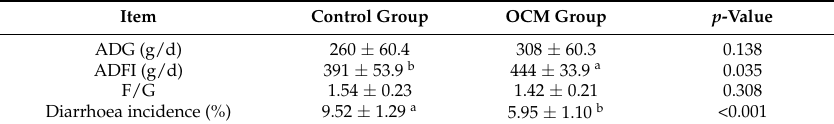
Table 1. Effects of dietary supplementation with OCM (50 mg/kg diet) on growth performance and diarrhoea incidence of piglets.